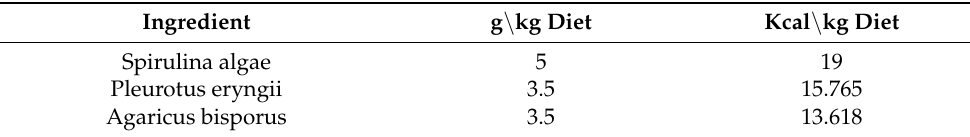
Table 3. Supplements added to the diet. Values are presented as gram per dry weight and as Kcal per dry weight of the supplements added to kg